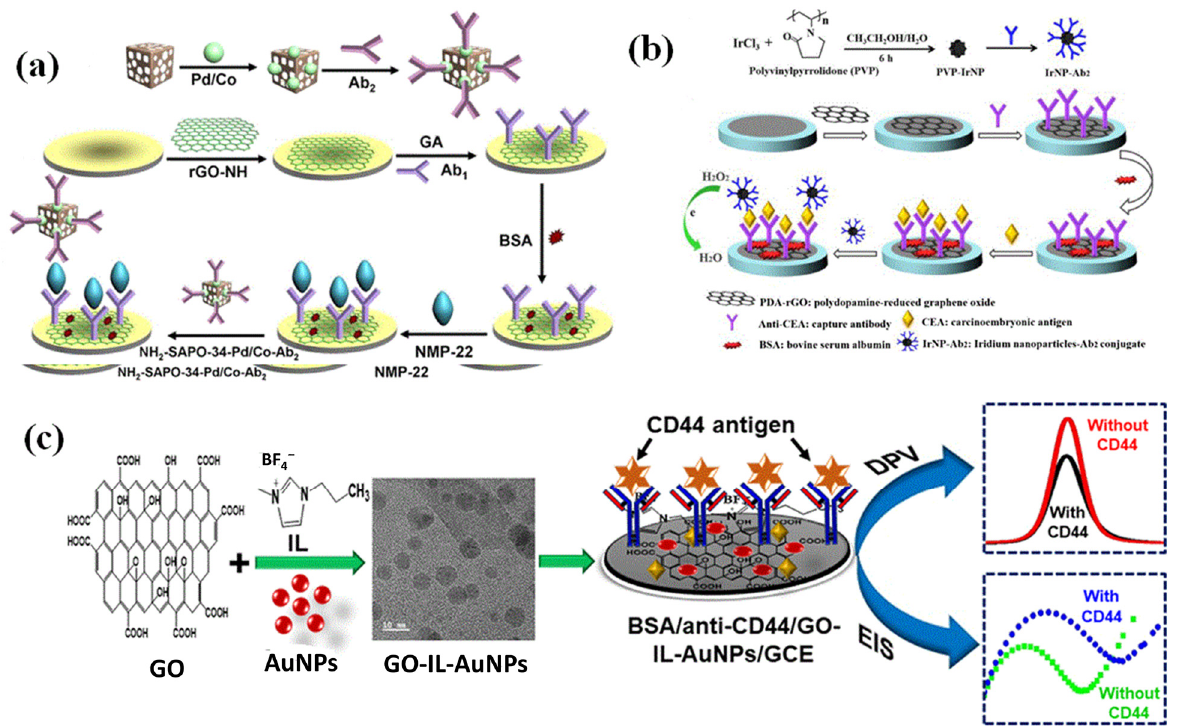
Figure 5. ( a ) A schematic diagram showing the fabrication of the NH 2 -SAPO-34-Pd/Co-Ab2 and the step-by-step construction of modified immunosensor. ( b ) The steps involved in making an electrochemical immunosensor for measuring carcinoembryonic antigen. ( c ) Fabrication of an electrochemical immunosensor to measure and identify the very sensitive breast cancer biomarker CD44 (cluster of differentiation-44). Reproduced with permission from [67–69].